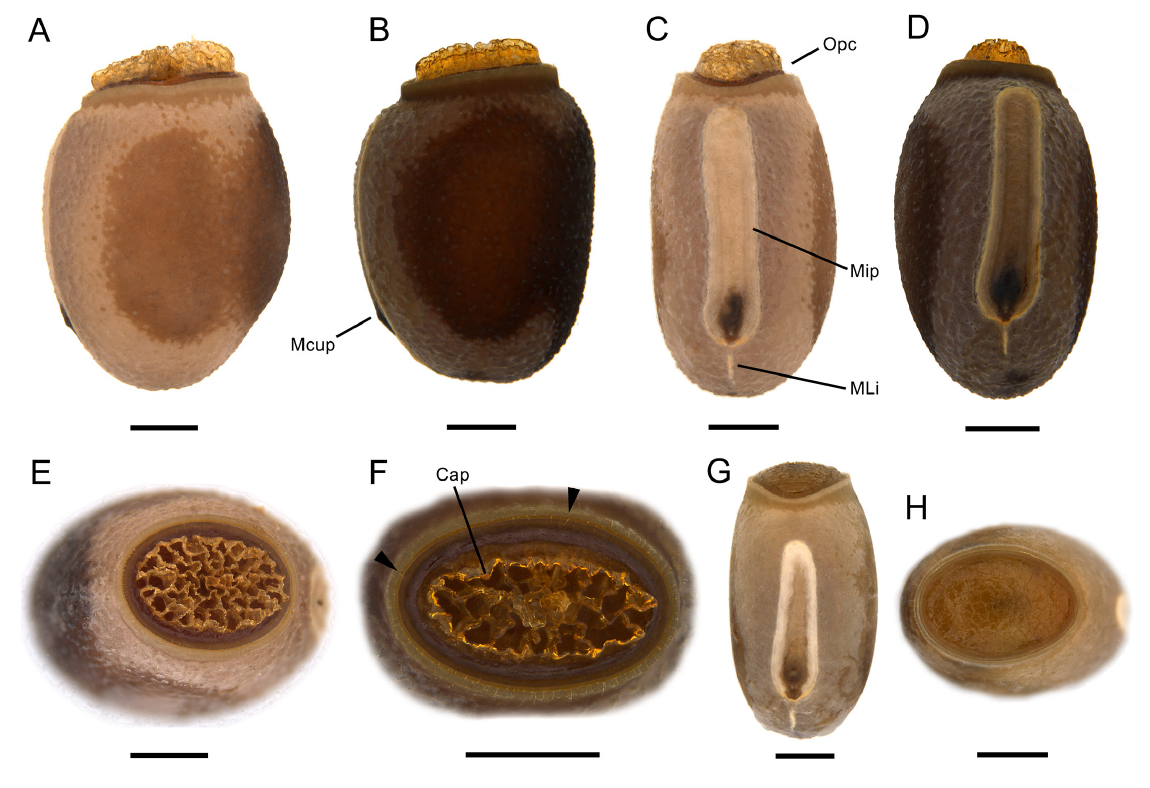
Fig. 12. Egg morphology of Arumatia dubia (Caudell, 1904) gen. et comb. nov. A, C, E, G, H . ♀ (MZUSP V0534) from Chapadão do Sul, Mato Grosso do Sul, Brazil. B, D, F . ♀ (MZUSP V0547) from Araguari, Minas Gerais, Brazil. A–B . Lateral view. C–D . Dorsal view. E–F . Anterior view, arrowheads pointing at bristles on opercular collar (F). G–H . Egg with flat operculum, dorsal (G) and anterior (H) views. Abbreviations: Cap = capitulum; Mcup = micropylar cup; Mip = micropylar plate; MLi = median line; Opc = operculum. Scale bars: 0.5